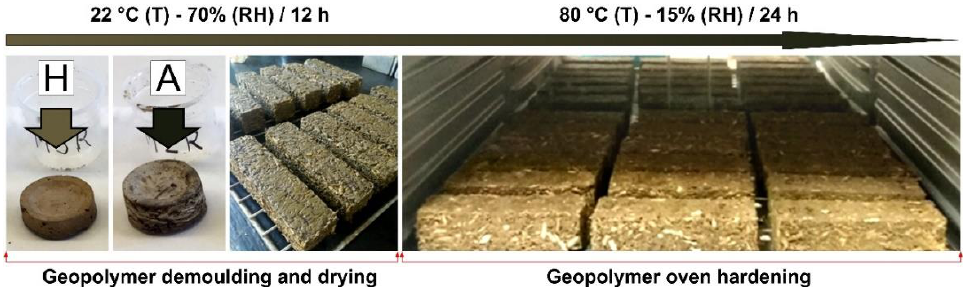
Figure 4. Demoulding, drying, and curing of the geopolymer concrete samples in an oven. The mineralogy, texture and microstructure of the samples was examined with a scanning electron microscope (SEM) (MODEL Zeiss DMS 950 coupled with Microanalysis Link QX 2000, ZEISS, Jena, Germany) and a polarized optical microscope (MODEL Olympus BX-60, Waltham, MA, USA).